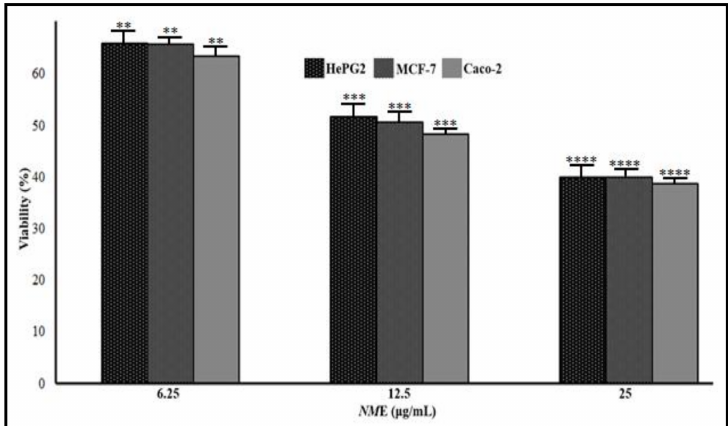
Figure 4. Effects of Nm E on HepG2, MCF-7, and Caco-2 cell viability after 48 h. Cells were incubated with the indicated concentration of Nm E while the percentage of cell viabilities were determined by MTT. Values used for plotting are means of triplicates, with each concentration tested in 7–8 wells. Statistical differences from control cultures are shown as bar graphs with error bars representing the means ± SD; ** p < 0.01, *** p < 0.001 and **** p <0.0001 vs. control (DMSO-treated) cells.